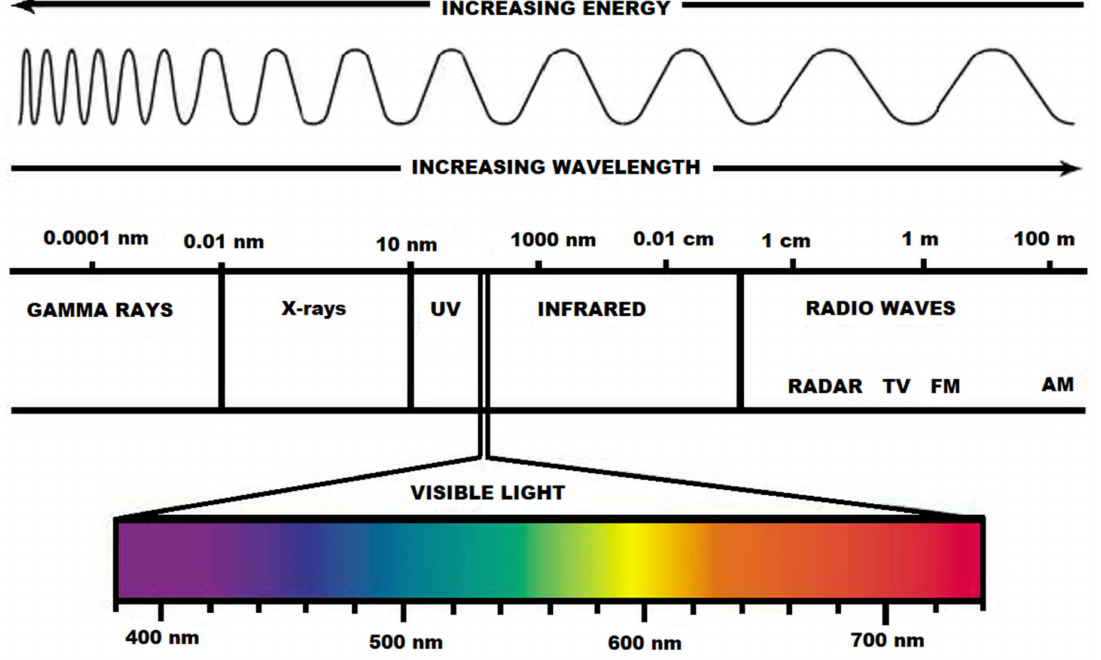
Figure 1. The aspect of the visible light spectrum within the electromagnetic radiation spectrum. Phototherapy is rooted in the past when Egyptian, Indian, Chinese, and later Greek civilizations used light as a therapeutic agent to cure psoriasis, rickets, vitiligo, and even skin cancers [123].